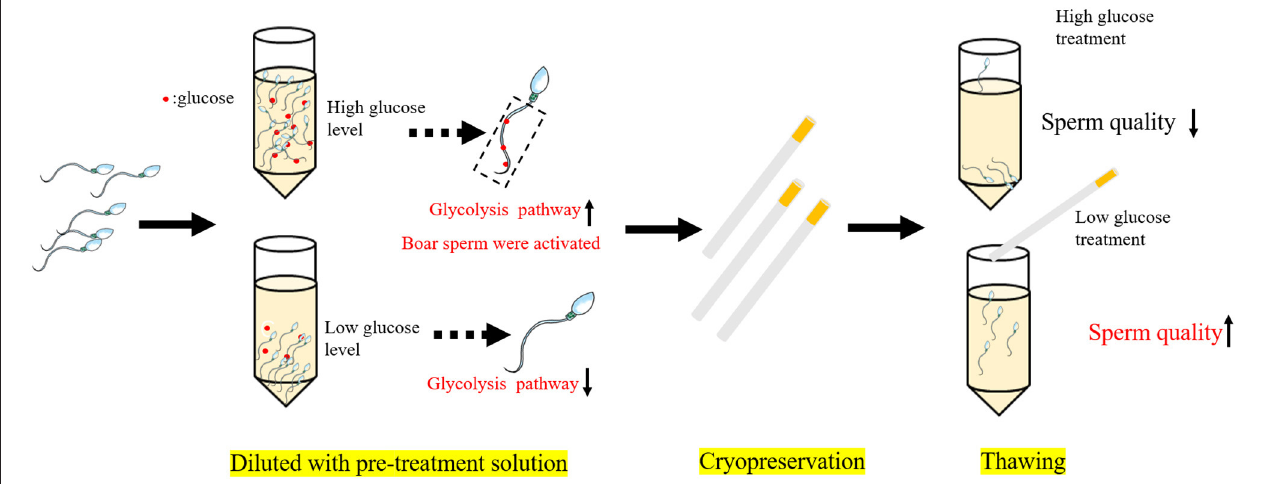
FIGURE 7 | Mechanisms of reducing the glucose level in the pre-treatment solution improve the boar post-thaw sperm quality. High glucose level in the pretreatment solution enhances the stimulation of the glycolysis pathway and led to the activation of boar sperm before cryopreservation, thus resulting in decreased boar post-thaw sperm quality, whereas reduction of the glucose level would inactivate the glycolysis pathway to increase the post-thaw sperm quality during